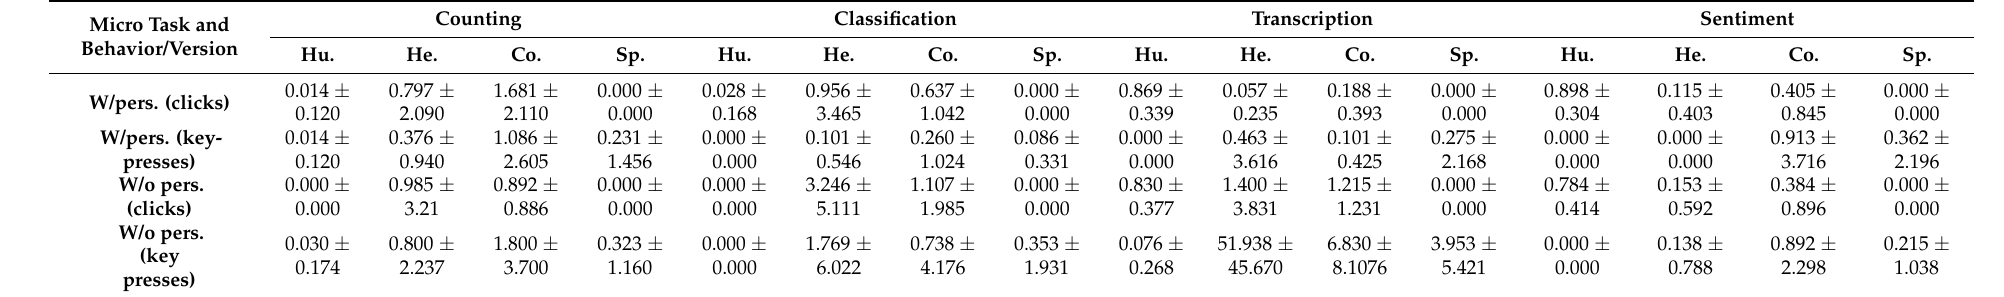
Table 3. Results of the identification of behavior traces (task fingerprinting) comprised of average and standard deviation values (both have 3 decimal digits) in the versions with and without personalization (‘W/o’—without, ‘W/’—with, ‘pers’—personalization, ‘Hu.’— hurry actions, ‘He.’— hesitant actions, ‘co.’—confident actions, “sp.”—special